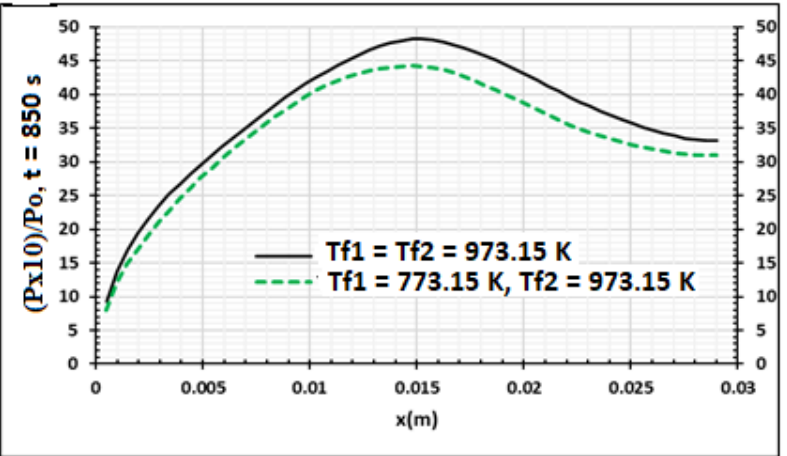
Figure 13. Wood relative pressure distribution at q 1 = q 2 = 0 W/m 2 using samples of 30 mm thickness, ρ bo = 700 kg/m 3 . Influence of the contact temperature, t = 850 s.